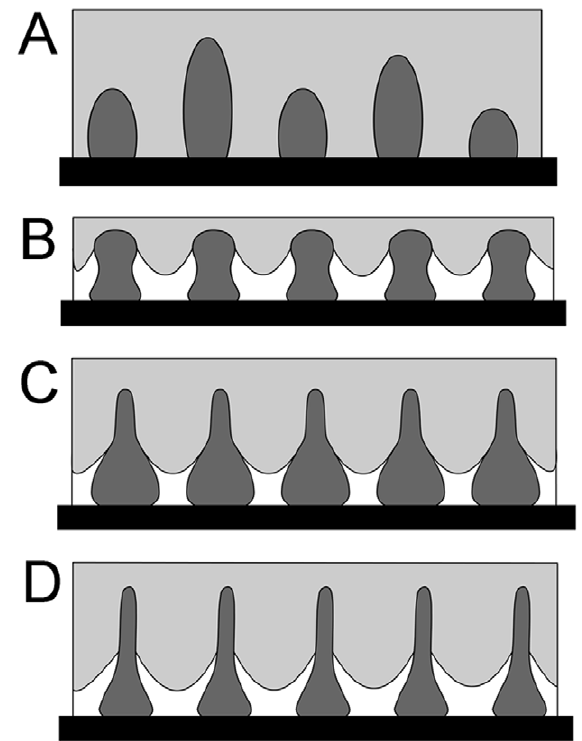
Figure 5. Schematic illustrations of a droplet of water in contact with the cicada wing surface. (A) Leptopsalta bifuscata ; (B) Aola bindusara ; (C) Meimuna opalifer ; (D) Cryptotympana atrata . The dark grey areas represent protrusions, the light grey areas show the water droplet remaining on the surfaces and the black lines show the interface of solid, liquid and